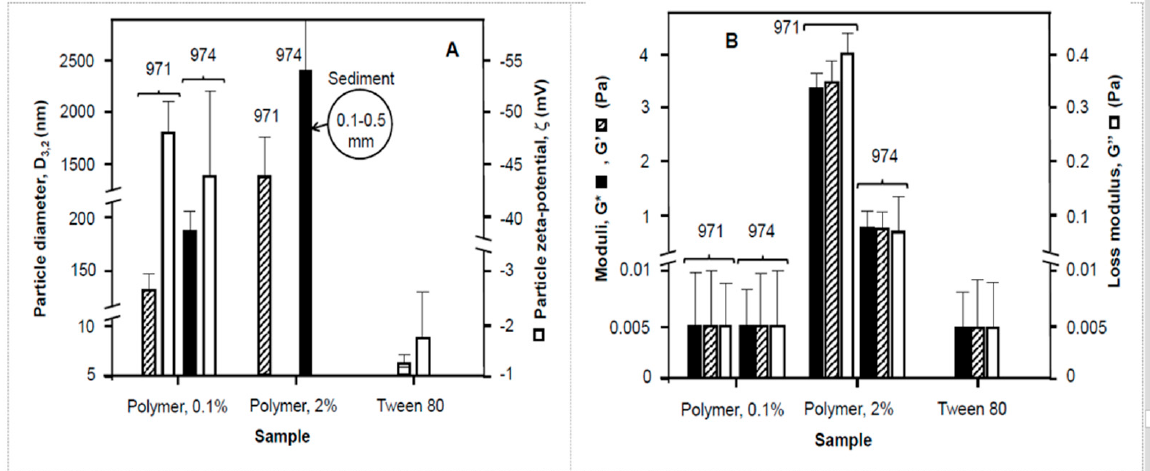
Figure 7. Multiple plot for the carbopol polymer colloidal suspensions, indicating average particle size (solid or hatched bars) and surface charge (unfilled bars) of suspended material ( A ) and also the complex modulus (solid bars), storage modulus (hatched bars), along with the loss modulus (unfilled bars) of suspensions ( B ) at 20 °C as a function of increasing bulk concentration, given as a percentage weight-in-volume (% w / v ). The polymer samples were carbopol 971P and carbopol 974P particle characterization and in rheological studies. Notably the carbopol 974P sample also showed evidence on inspection of limited sedimentation after more than 30 min in the preparation vessel, with particles in the submillimeter size. All solutions used for samples were prepared from surface chemically pure 50 mM sodium phosphate buffered water, pH 7.0.